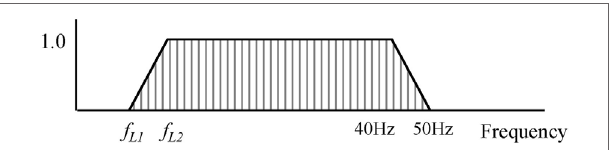
FigUre 3 | Band-pass